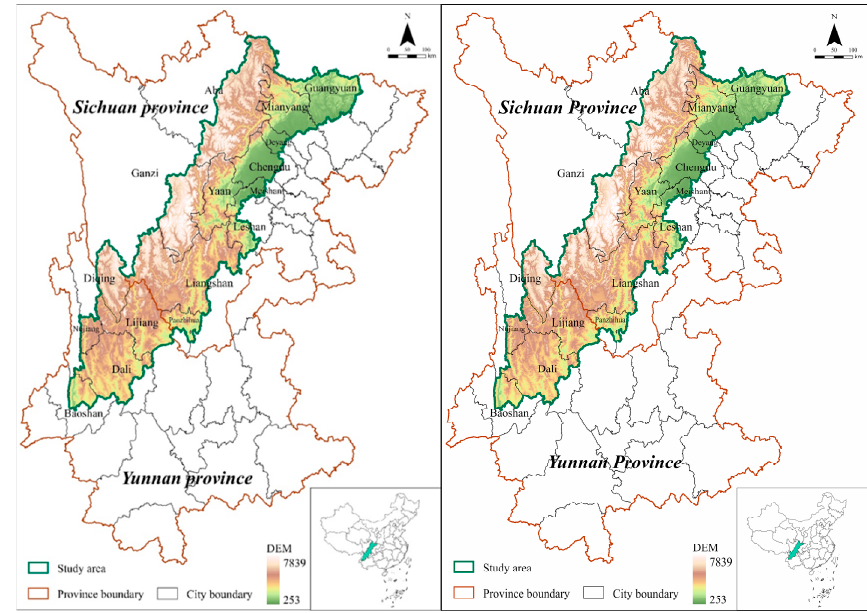
Figure 1. Study area.